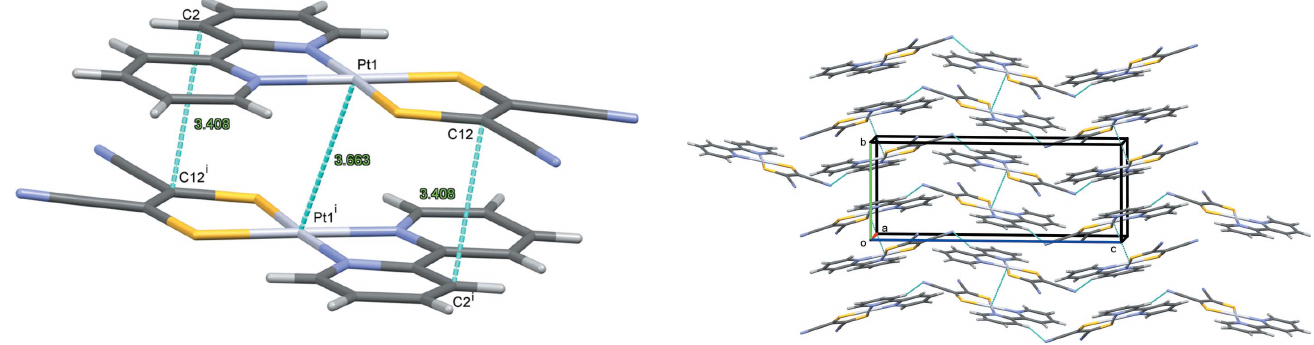
Figure 3 A view along the a axis of the crystal packing of the title compound.